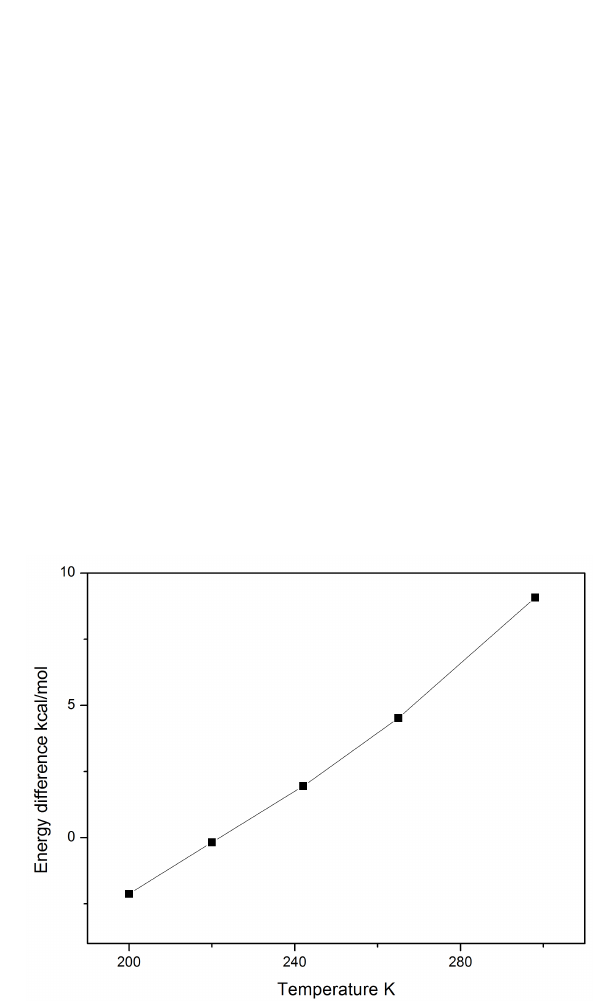
Fig. 3. Free energy difference between three and four sulfuric acid ionic clusters, for 220K and 200K points we used the same con- centrations as given for 1G 1 in Table